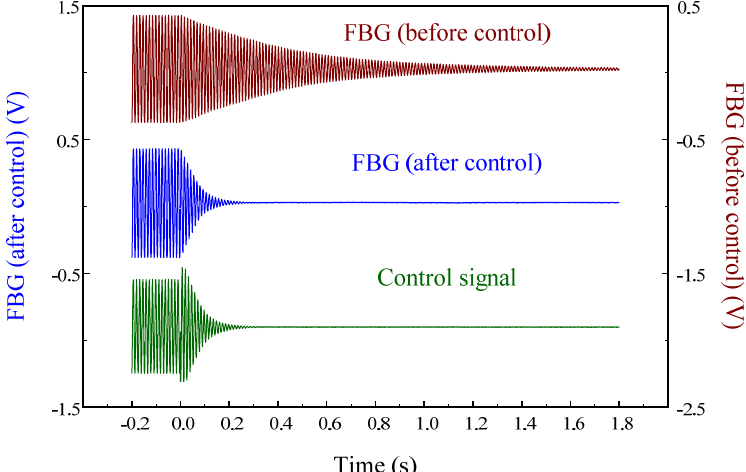
Figure 25. Active vibration control of the smart cantilever beam excited at first resonant frequency (76 Hz) obtained from FBG displacement sensor.